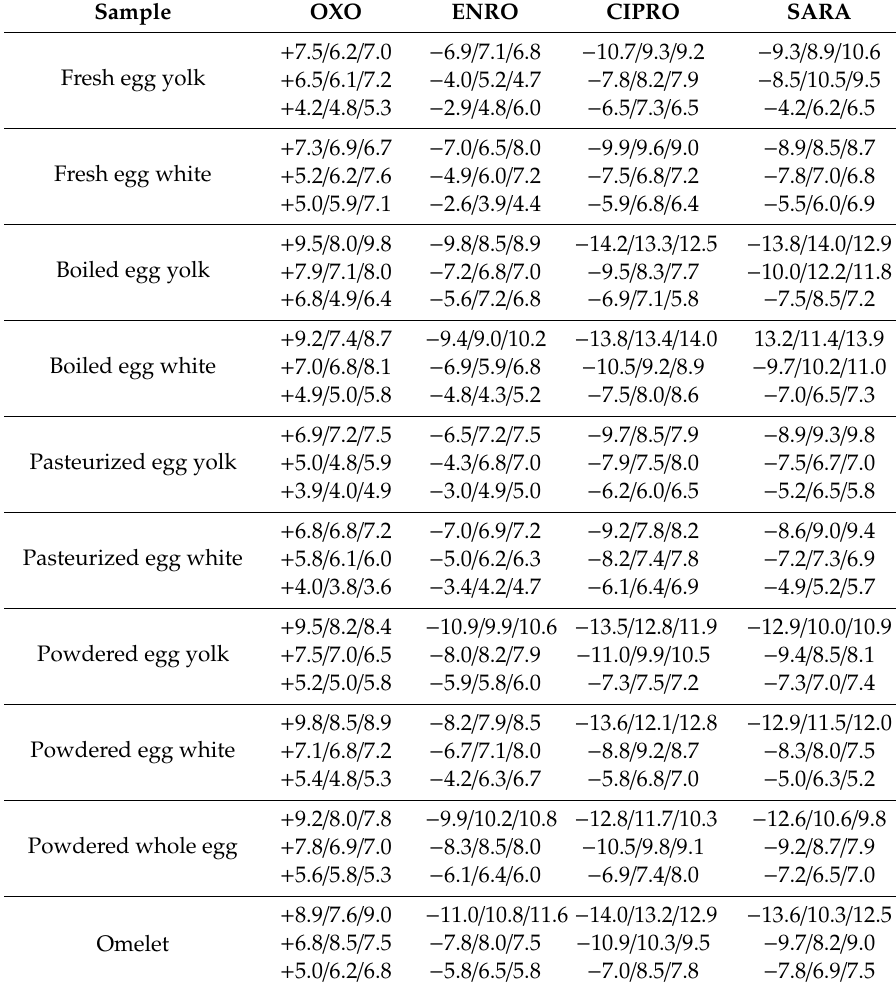
Table 3. Trueness (%), repeatability 1 , and within-laboratory reproducibility 2 (RSD, %) values for the quantification of the studied quinolones in fresh eggs and several egg-derived foodstu ff (acceptance criteria: trueness, − 20 to + 10%; precision, < 15.1%). For each matrix, the first, second, and third lines refer to the fortified amount MRPL, 1.5 × MRPL, and 2 ×